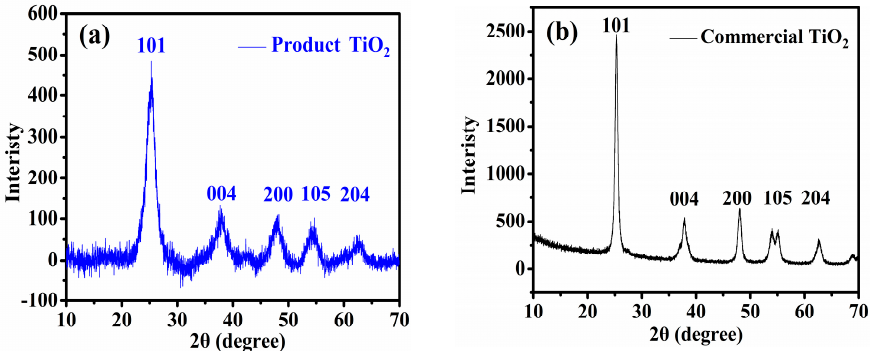
Figure 5. XRD pattern of product TiO 2 ( a ) compared with commercial TiO 2 ( b ).